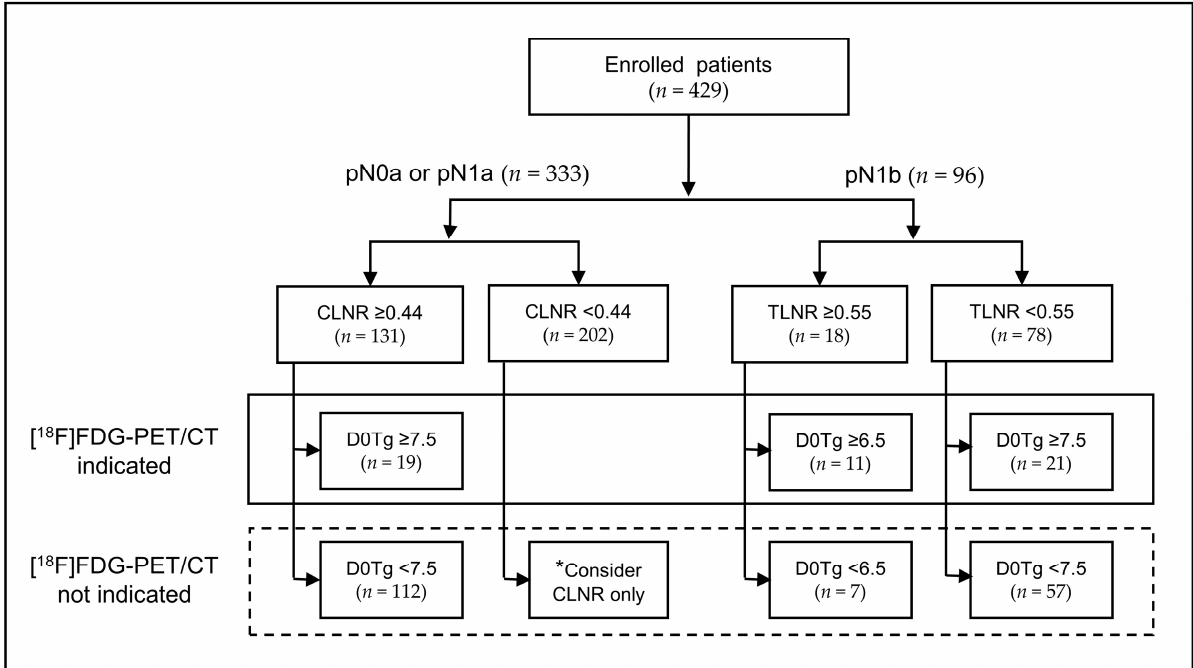
Figure 2. Distribution of patients according to the diagnostic criteria using the metastatic lymph nodes ratio (LNR) and the serum level of thyroglobulin obtained immediately before RAI therapy (D0Tg). * All patients with central LNR <0.44 were classified into the group with no indication for [ 18 F]FDG-PET/CT because the optimal cut-off value of D0Tg was not available. (CNLR, central metastatic lymph nodes ratio; D0Tg, serum level of thyroglobulin (ng/mL) obtained immediately before RAI therapy; TLNR, total metastatic lymph nodes ratio).